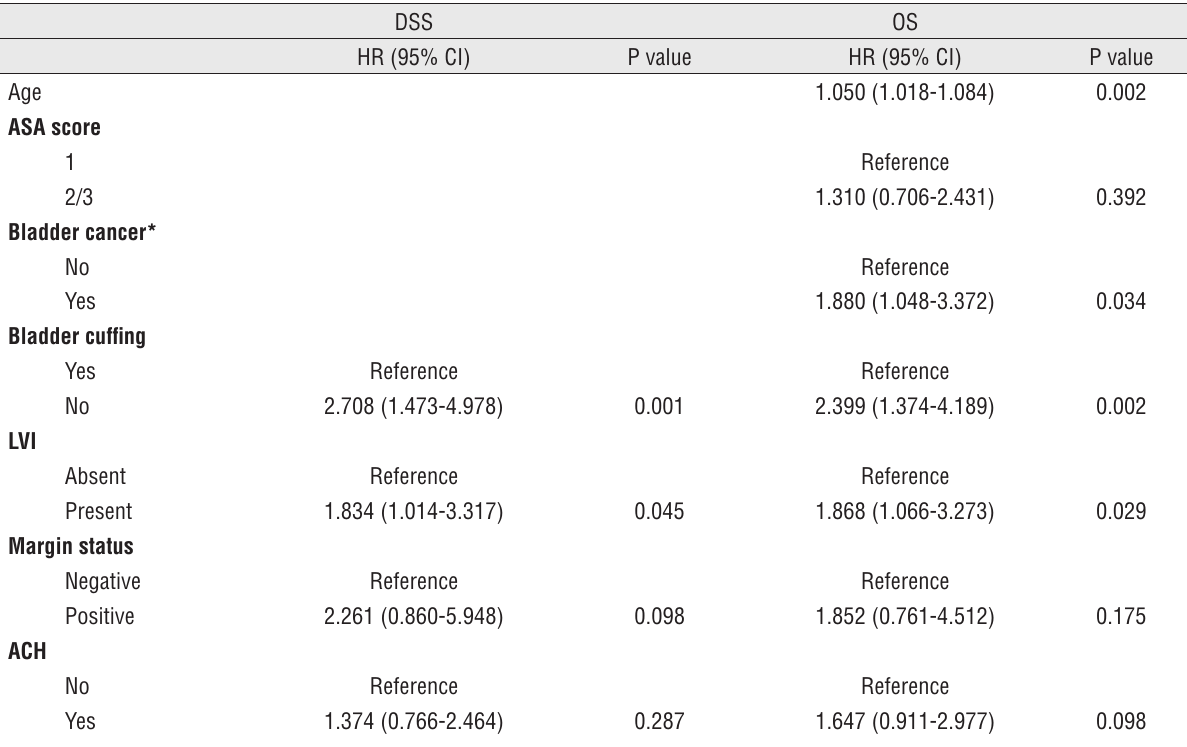
supplementary Table-2: Multivariate Cox proportional hazards regression analysis of disease-specific survival and overall survival in patients who received cisplatin-based adjuvant chemotherapy or